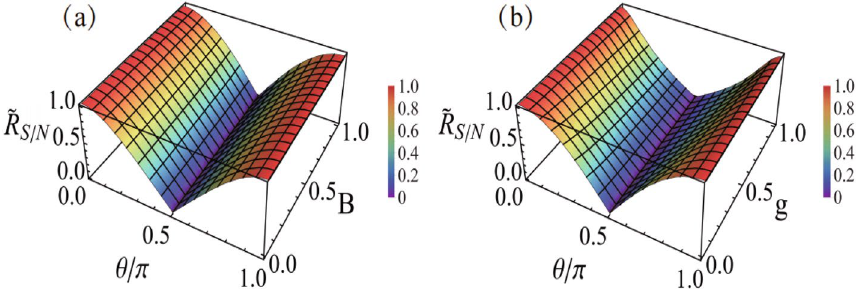
Figure 3. Numerical results of the SNR versus the pre- and post-selection parameters B and θ in ( a ), and the feature of weak dependence on the measurement strength g in ( b ). The reduced results plotted by scaling with the SNR of conventional measurement R post-selection). In ( a ) and ( b ), g